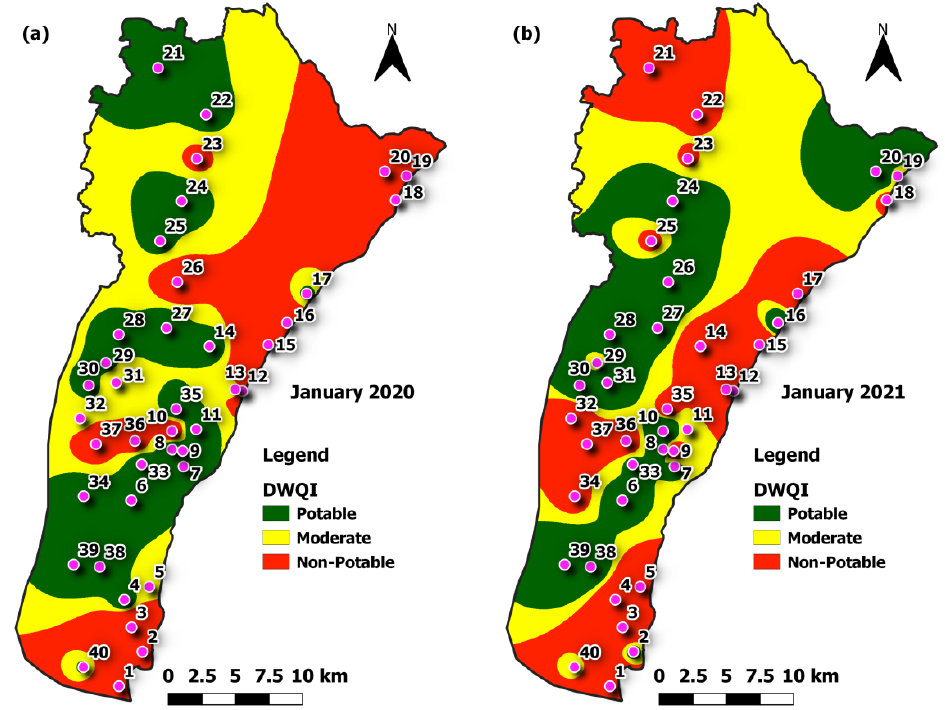
Figure 3. Spatial distribution maps of the calculated DWQI for ( a ) January 2020 and ( b ) January 2021.